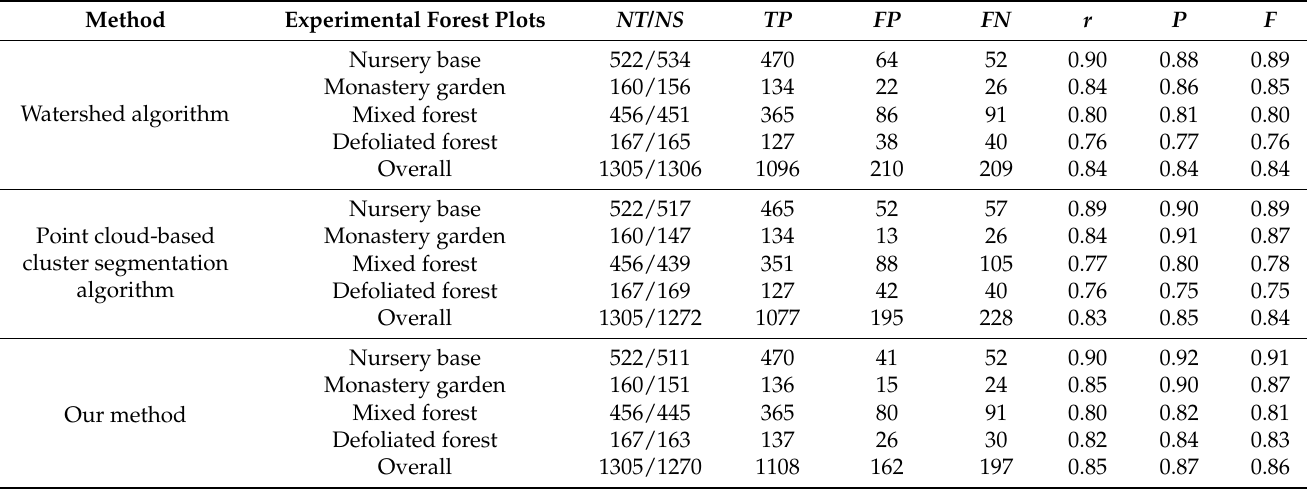
Table 4. Comparison of the accuracies of ITC segmentation using watershed algorithm, point cloud-based cluster segmenta- tion algorithm and our method on raw point clouds of the same four experimental forest sites. Method